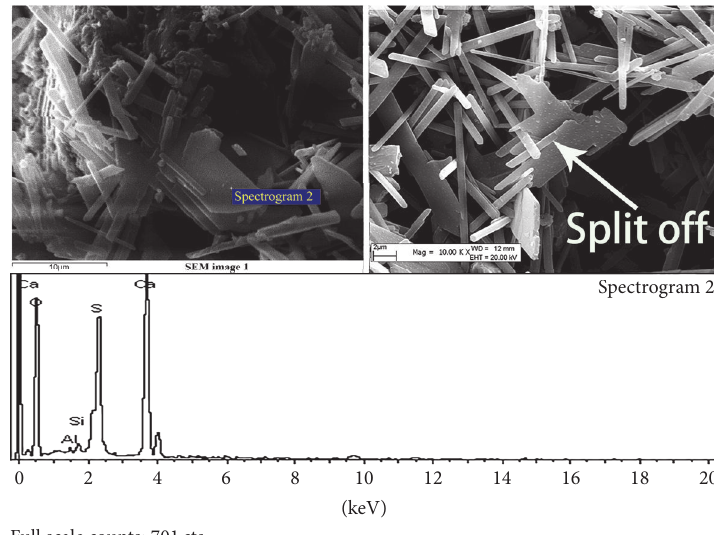
Figure 6: Surface morphologies and chemical compositions before and after hydration reaction.